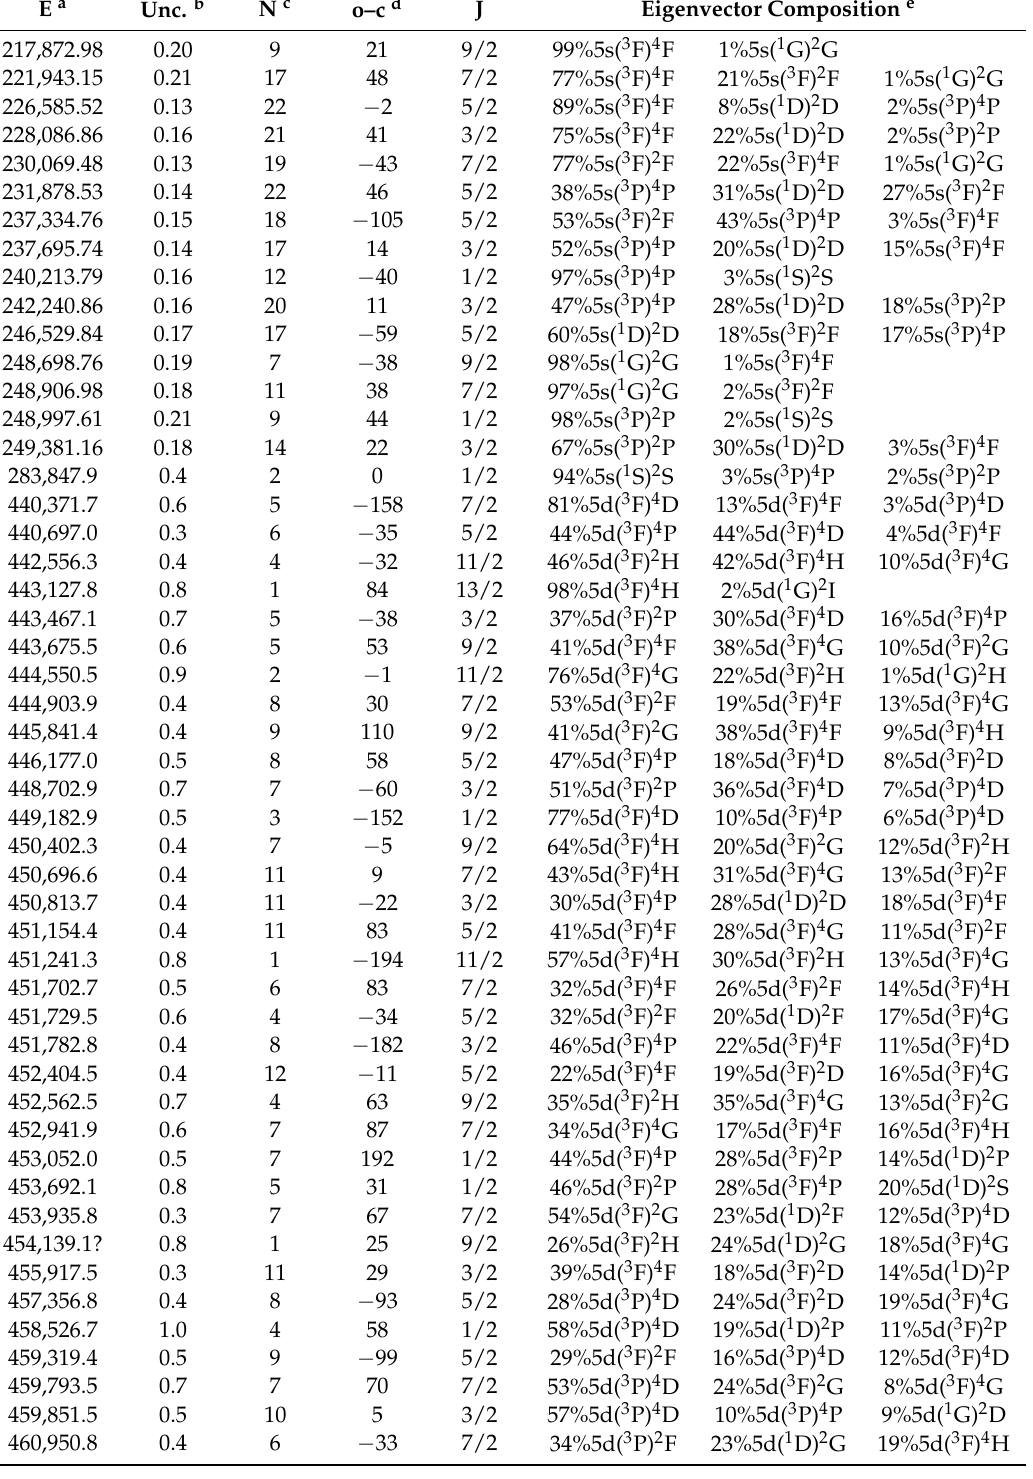
Table A2. Level energies (in cm − 1 ) of the 4d 8 5s, 4d 8 6s and 4d 8 5d configurations of Sn